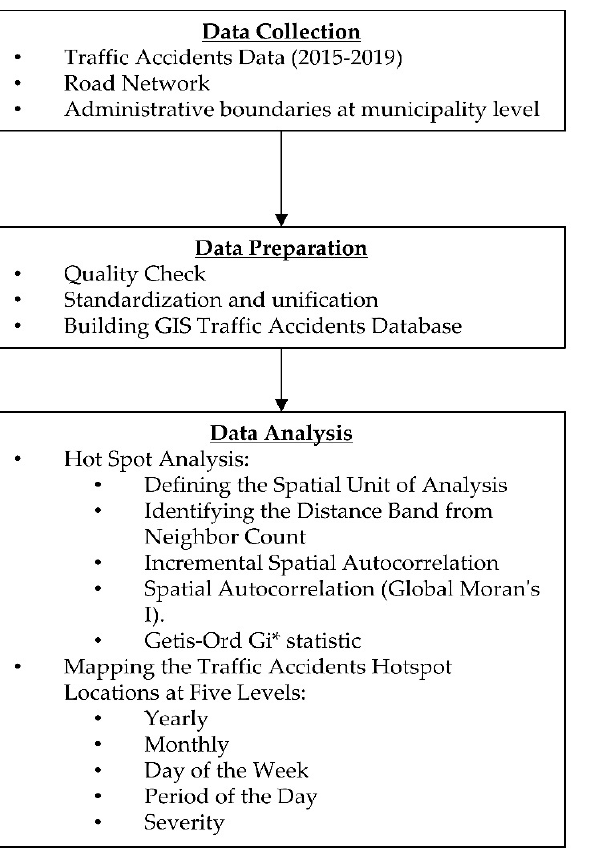
Figure 2. Schematic diagram of the implemented procedures for mapping traffic-accident hotspot locations.